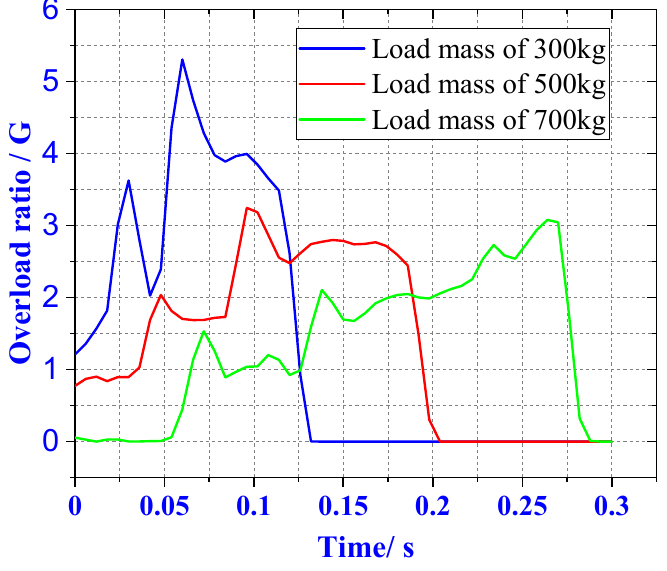
Figure 10. Three load overload rate curves.